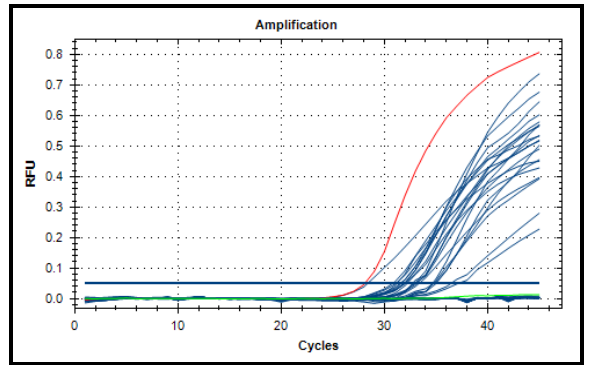
Figure, 1: Real-Time PCR amplification plot for Babesia bovis in positive and negative samples.